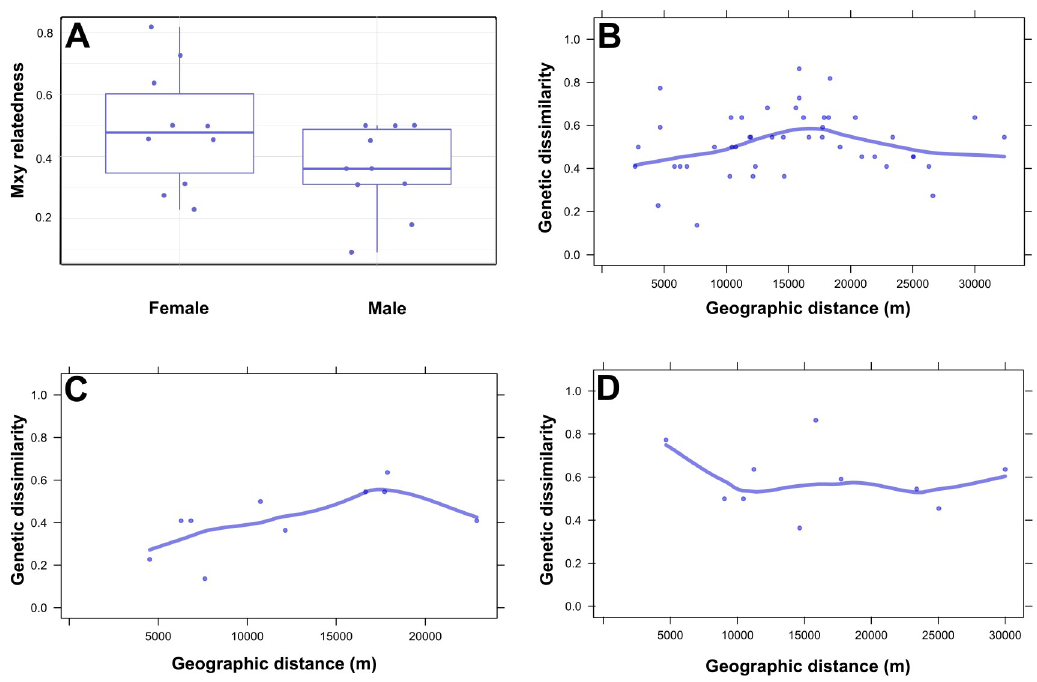
Fig 2. Relatedness and spatial organization of territorial lynx in northwestern Anatolia. M and male territorial lynx in northwestern Anatolia. Plots of genetic dissimilarity (Kosman and Leonard, 2005; n loci = 11) versus geographic distance, for (B) all territorial lynx (n genotypes = 10), (C) for territorial females (n genotypes = 5) and (D) territorial resident males (n genotypes =